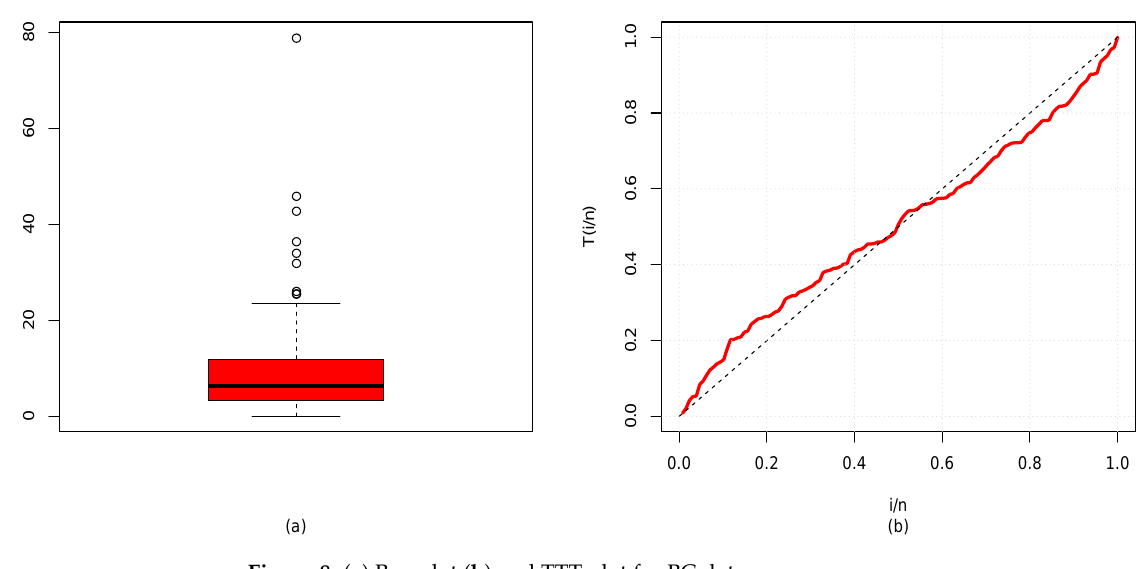
Figure 8. ( a ) Box plot ( b ) and TTT plot for BC